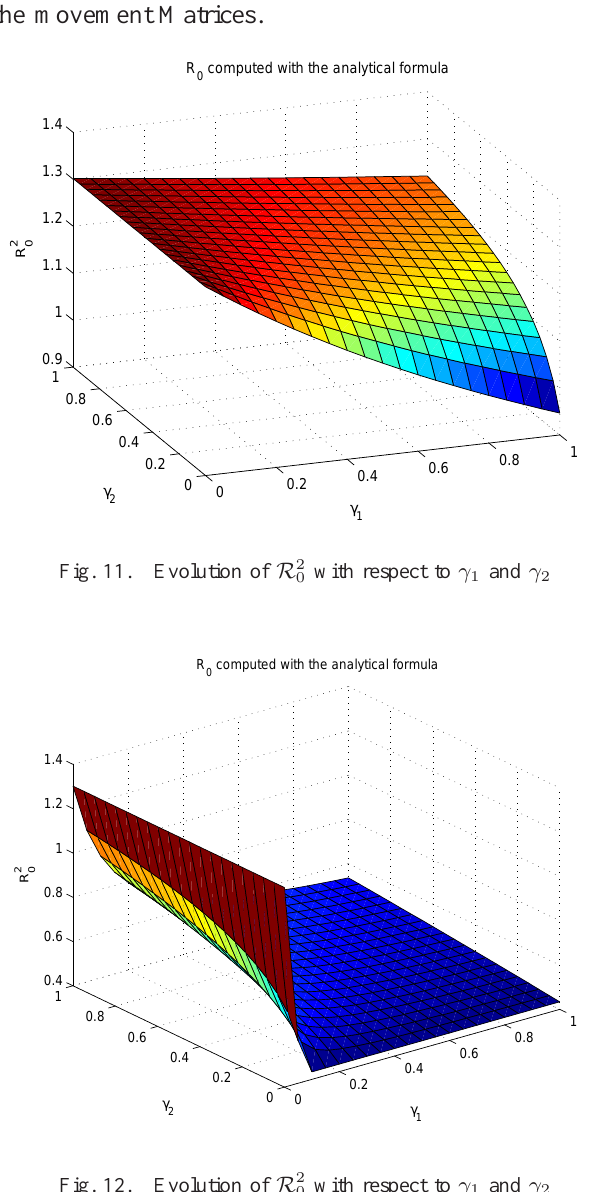
Fig. 12. Evolution of R 2 0 with respect to γ 1 and γ